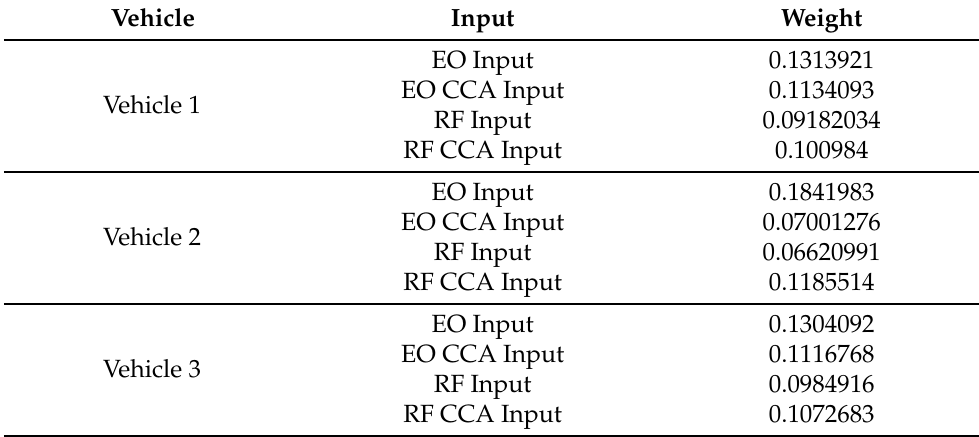
Table 3. explainX.ai weight results for Scenario 2C.